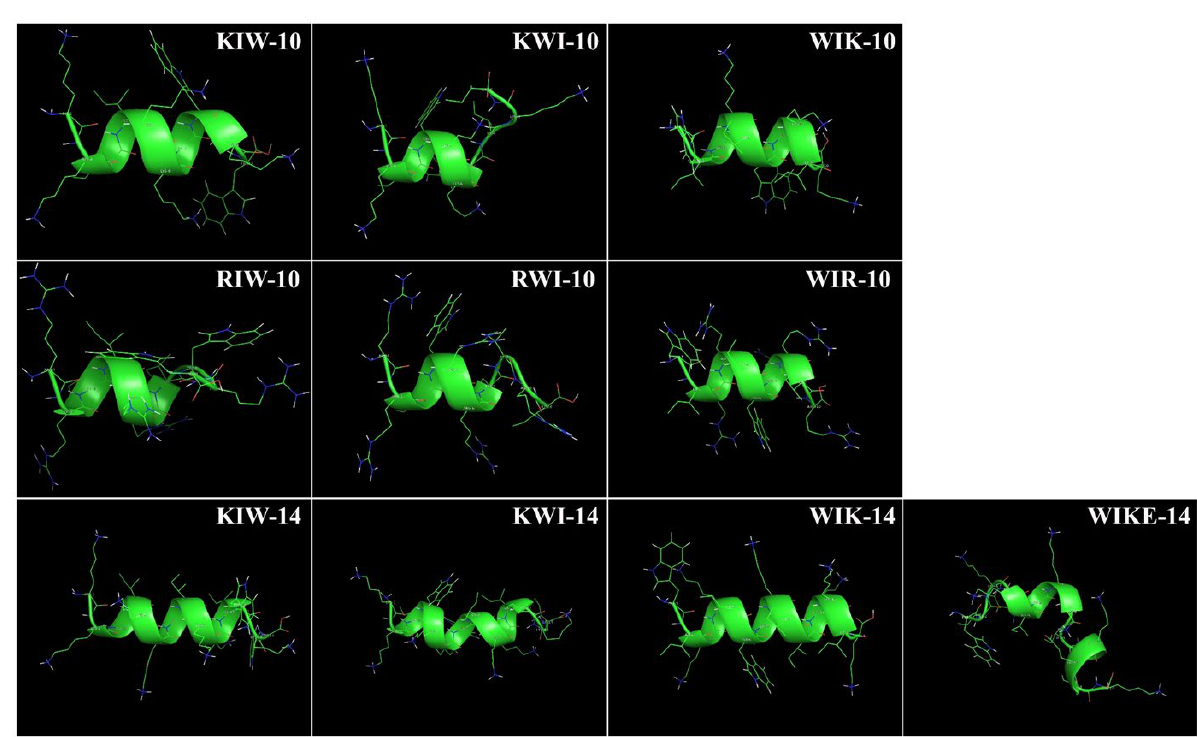
Figure 1. PEP-FOLD model of KXW peptides. Structures of designed peptides were modeled using PEP_FOLD server (http://mobyle.rpbs.univ-paris-diderot.fr/cgi-bin/portal.py#forms::PEP-FOLD).